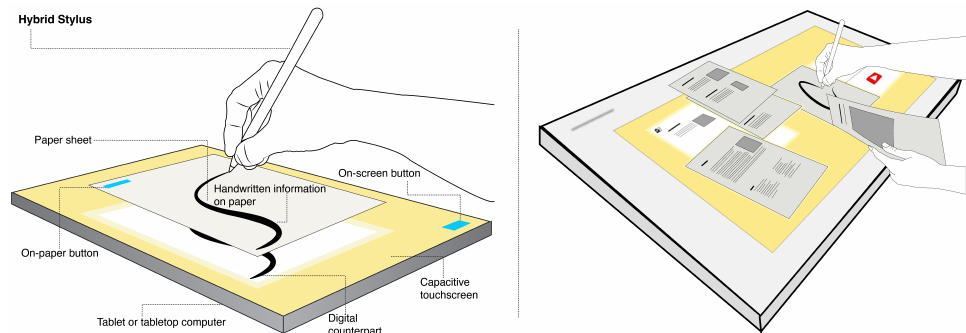
Figure 1. The Hybrid Stylus concept. Left: When a paper is placed on a tabletop touchscreen, the user can use the stylus to write on it and simultaneously capture handwritten information in the digital form. The stylus also preserves all capabilities for touchscreen interaction only or can be used solely on paper. Note that the offset between the paper and screen is used only for illustrating digitisation. Right: The vision of using the stylus interchangeably on paper and tabletop computer desk. When a paper document is placed on such a screen, it merges into the surrounding context and the ecosystem of the underlying digital